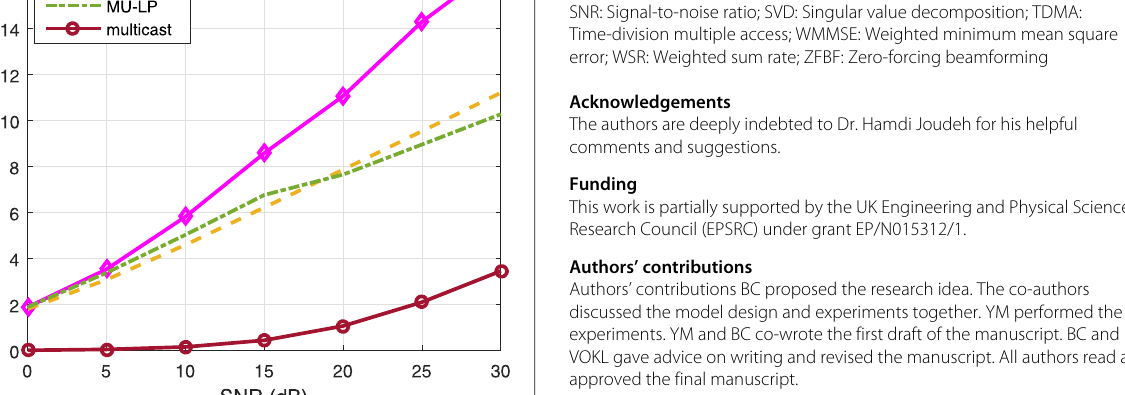
Fig. 61 Weighted sum rate versus SNR comparison of different strategies for overloaded ten-user deployment with perfect CSIT, = 1, σ 2 = 0.9, ...σ 2 = 0.1, N = 2, SNR=30 dB, σ 2 t 1 2 10 r th = [0,0.001,0.004,0.01,0.03,0.06,0.1]